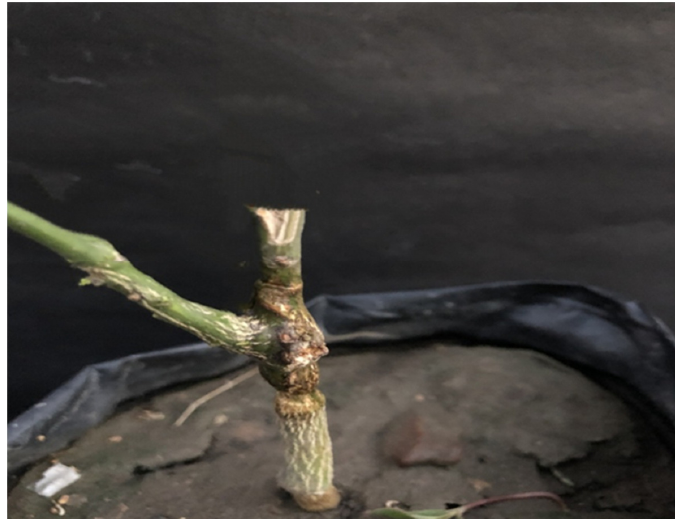
Figure 4. A view of healed bud union of sweet orange cv. ‘Blood Red’